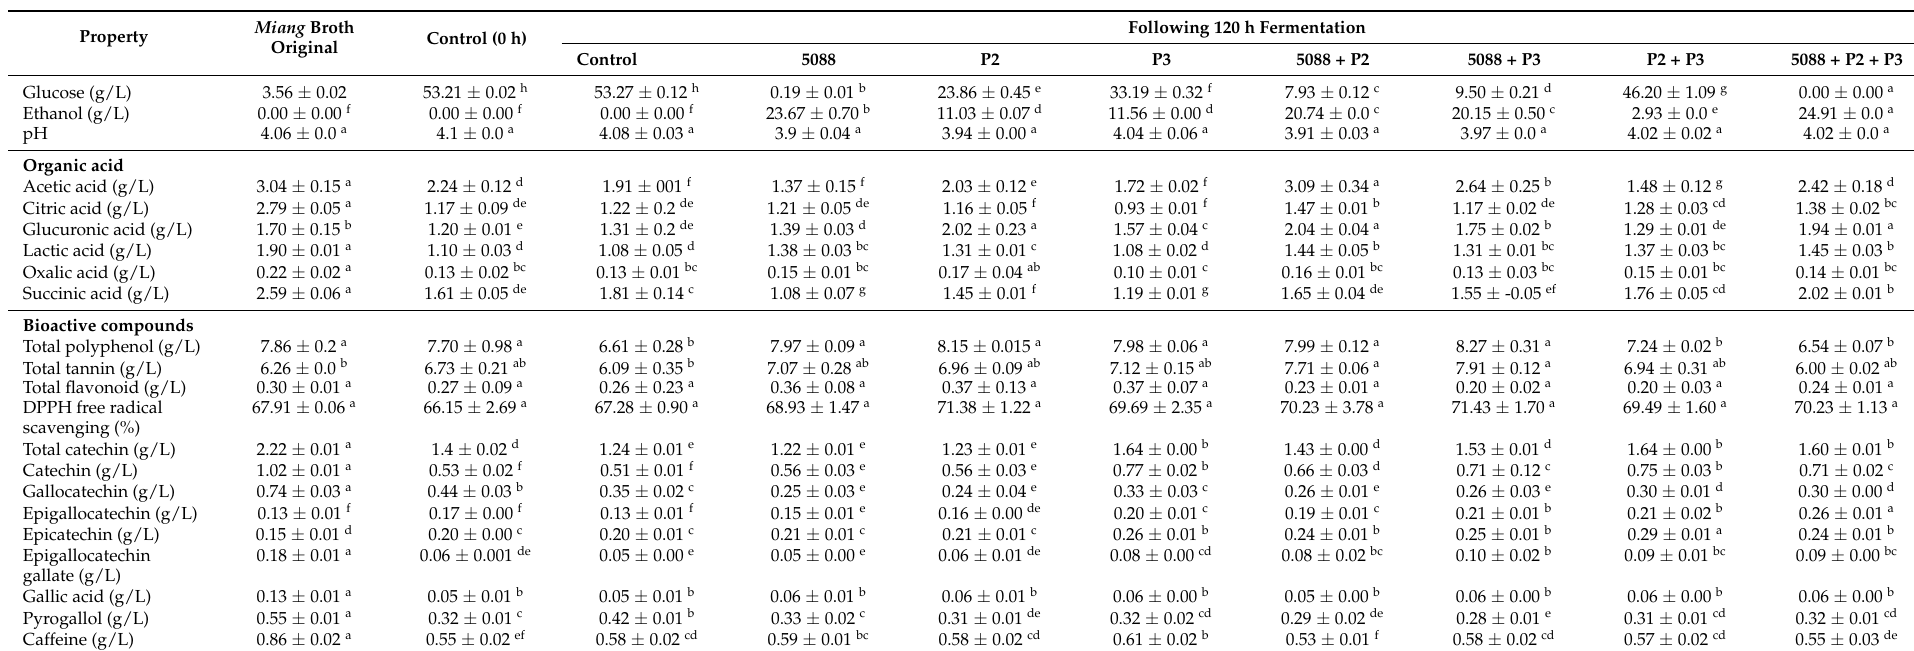
Table 3. Physicochemical properties of fermented Miang broth with single and co-cultures of S. cerevisiae TISTR 5088, W. anomalus P2 and C. rhodanensis P3 at 120 h after